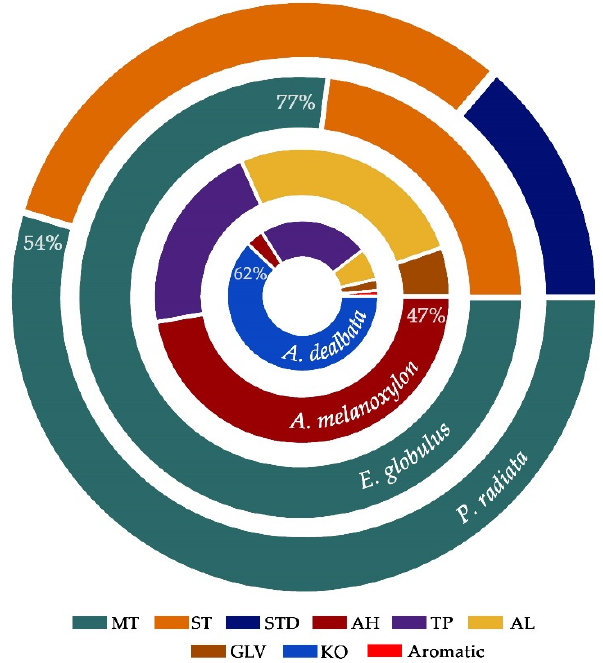
Figure 4. Distribution of main chemical compounds by chemical classes, according to concentration results obtained from extracts of fresh leaves of exotic forest species, as proportions of the total content. MT: monoterpenes; ST: sesquiterpenes; STD: steroids; AH: aliphatic hydrocarbons; TP: triterpenes; AL: aldehydes; GLV: green leaf volatiles; KO: ketones. The main chemical compounds that predominated were as follows— E. globulus : eucalyp- tol (51.01 ± 5.46%, MT), alpha-pinene (16.27 ± 2.85%, MT), and aromadendrene (7.62 ± 2.40%, ST); P. radiata : beta-pinene (22.91 ± 16.68%, MT), 13-epimanool (18.28 ± 18.48%, ST),